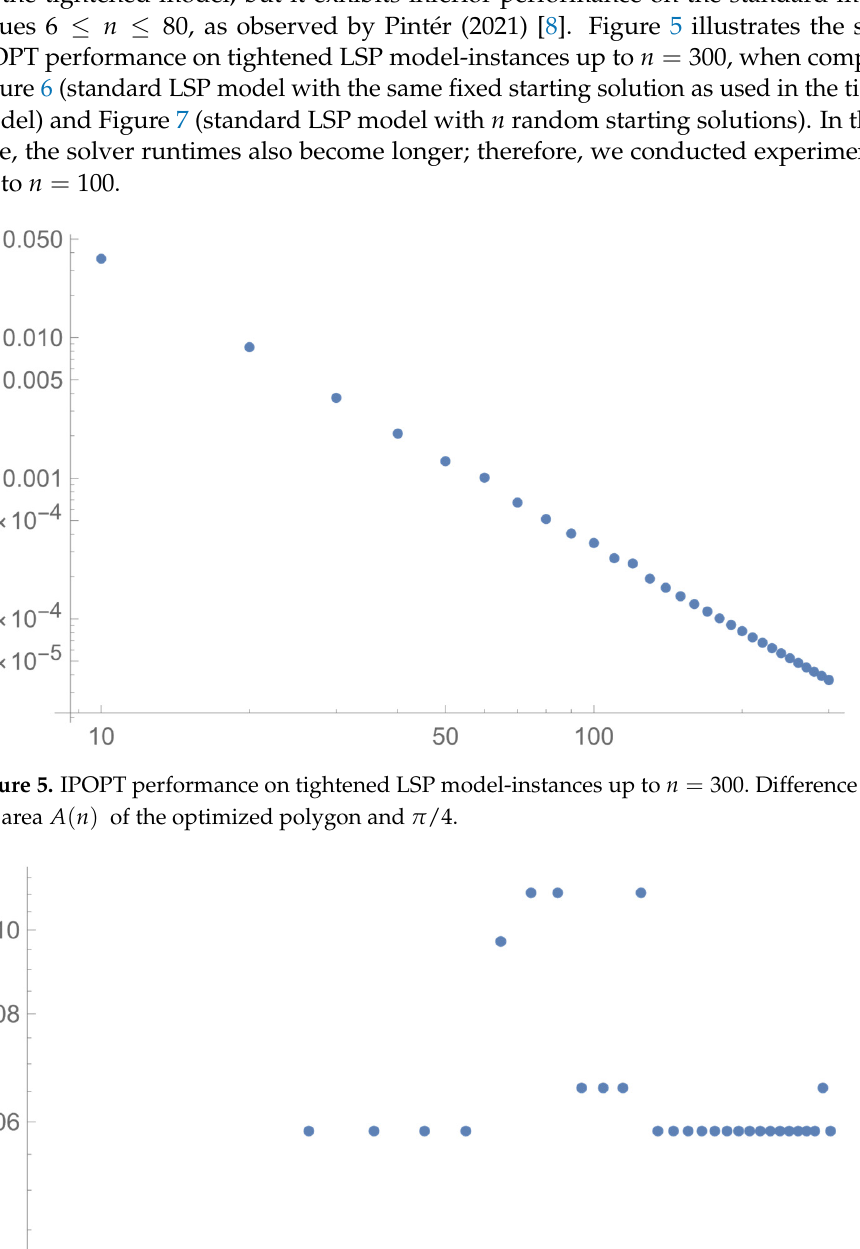
Figure 7. IPOPT performance on standard LSP model-instances, with random starting solutions up to 𝑛 = 100. Difference between the area 𝐴(𝑛) of the optimized polygon and 𝜋 4⁄ . 4. 𝑳𝑺𝑷 ( 𝒏 ) Regression Model for Even 𝒏 As it is known, and illustrated by Figures 2 and 3, for large 𝑛 the optimal 𝐿𝑆𝑃(𝑛) configuration approaches the circle with unit diameter; hence the corresponding area limit is 𝐴(∞) = 𝜋 4⁄ ~0.7853981634 . Comparing this limit value to our optimum estimate ob- tained for 𝐴(1000)~0.7853949284 , the ratio 𝐴(1000) (𝜋 4⁄ )⁄ approximately equals 0.9999958811 . Hence, our 𝐴(1000) estimate already leads to a fairly close approxima- tion of the limit value. Based on this observation and using our numerical results, we developed the follow- ing regression model for even values of 𝑛 . 𝐴(𝑛)~ 𝜋 4 − 5𝜋 (cid:2871) 48𝑛 (cid:2870) − 3.530190 (cid:3436) 1 𝑛 (cid:2871) (cid:3440) − 2.391836 (cid:3436) 1 𝑛 (cid:2872) (cid:3440) − 19.489487 (cid:3436) 1 𝑛 (cid:2873) (cid:3440).